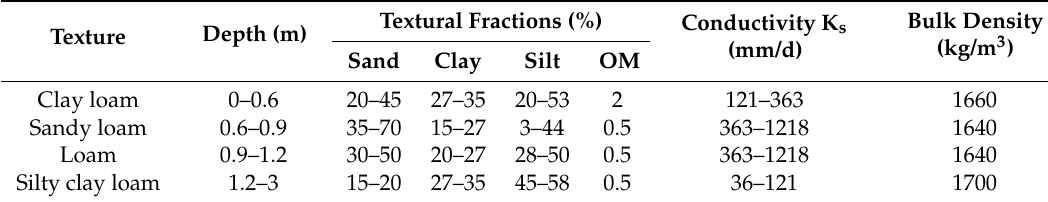
Table 1. Average soil profile texture variations in the study region